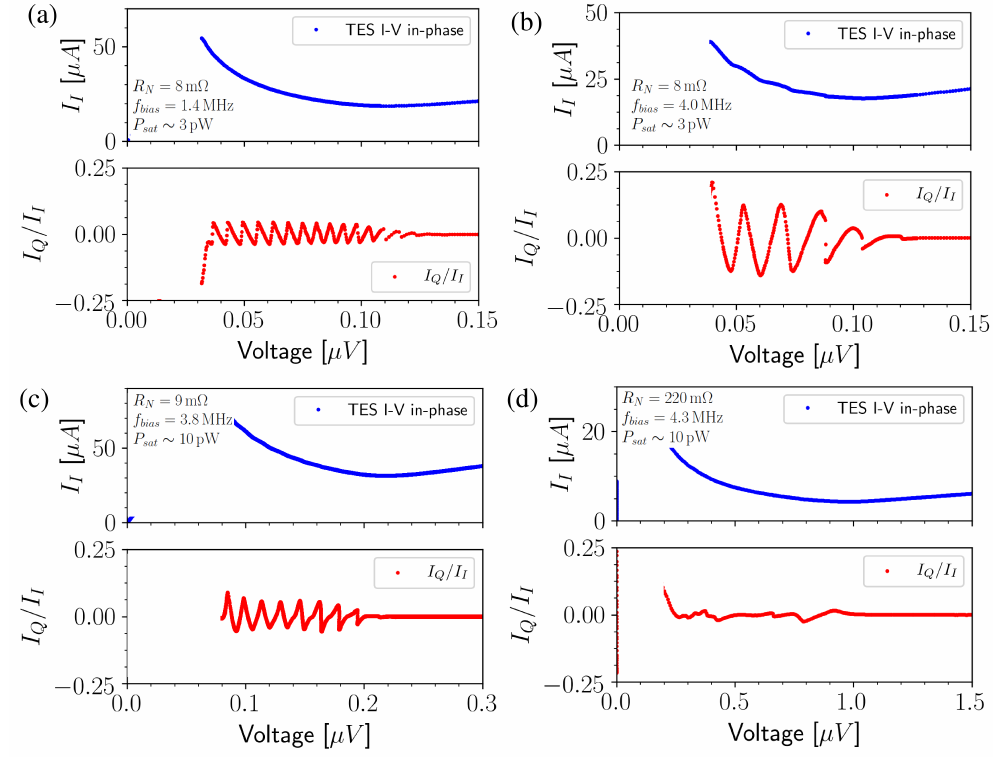
Figure 10. TES I–V curves for different X-ray microcalorimeter types and MHz bias frequencies. In the lower graph of each plot the ratio I Q / I I of the quadrature or Josephson ( I Q ) and in-phase I I current is shown. In ( a – c ), the bias frequency is, respectively, f bias = 1.4,4.0and3.8MHz. The de- tector is an NASA-GSFC Mo/Au bare TES [113,117] with R N (cid:39) 8–9 m Ω and P sat ∼ 3pW( a , b ) and P sat ∼ 10pW, respectively. In ( d ), we consider a Ti/Au, 130 × 140 µ m, SRON TES [108] with R N (cid:39) 220 m Ω , P sat ∼ 10pW, and biased at frequency f bias = 4.3MHz. Reprinted from [119]